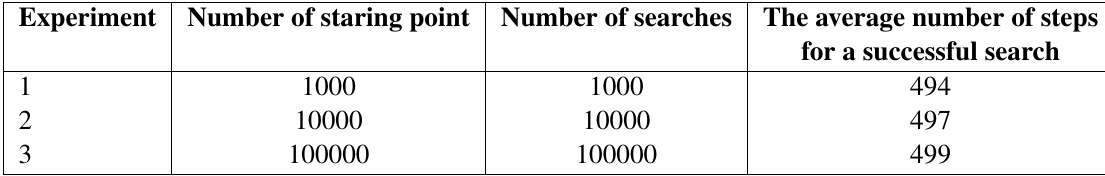
Table 7 Random search to find the average search step for the